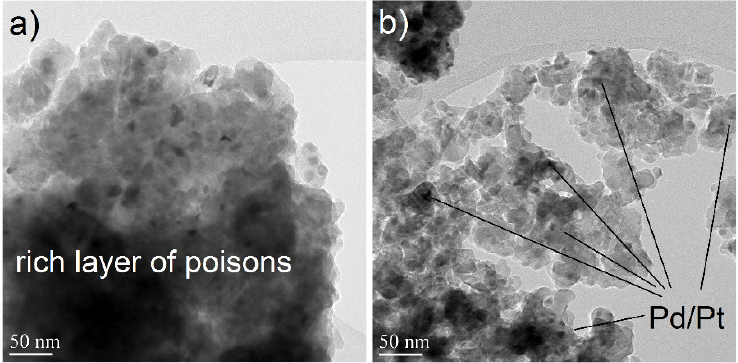
Figure 15. TEM images from the vehicle-aged natural gas catalyst ( a ) inlet, ( b ) outlet.